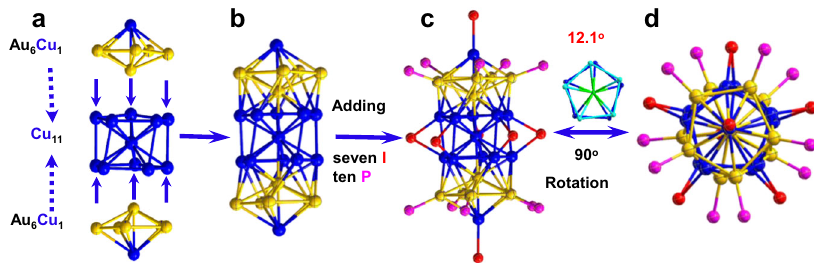
Fig. 3 Con fi guration of Au 12 Cu 13 cluster. a , b Anatomy of Au 12 Cu 13 cluster. c Side view and d top view. Color code: Au, yellow; Cu, blue and cyan; I, red; P, pink. Note that the other atoms are omitted for